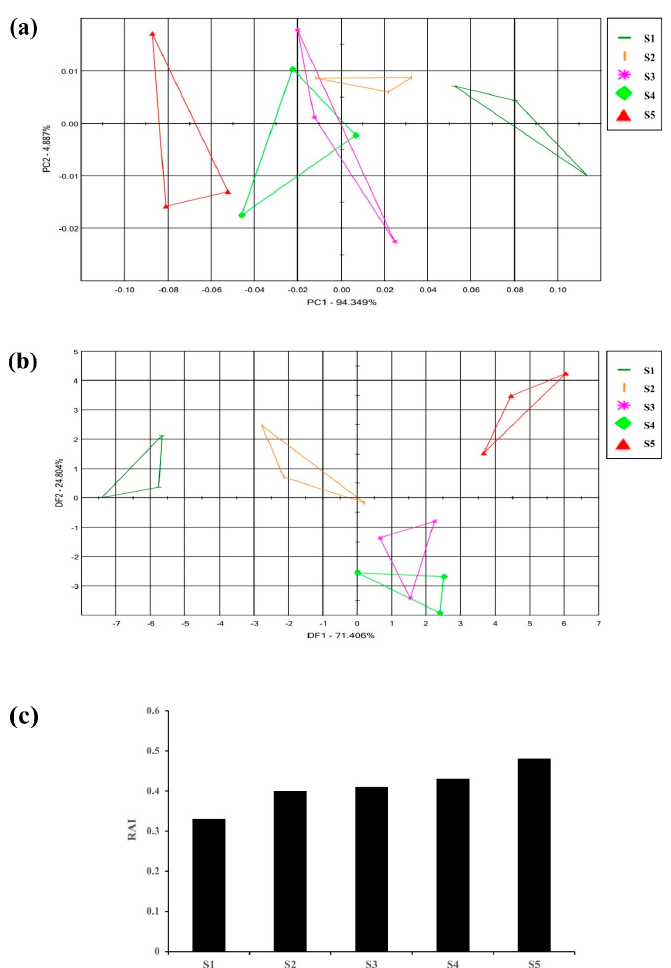
Figure 2. Floral scent patterns of different flowering stages of Aster yomena were distinguished by principle component analysis ( a ) discriminant factor analysis; ( b ) graph representing the relative aroma intensity of different flowering stages; ( c ) S1-Tight bud stage, S2-Bud developing stage, S3-Initial blooming stage, S4-Almost opened flower stage, S5-Fully opened flower stage. DFA score plots of the Aster yomena E-nose data were plotted as two-dimensional DFA score plots with two principal components (DF1 and DF2) accounting for 71.406%